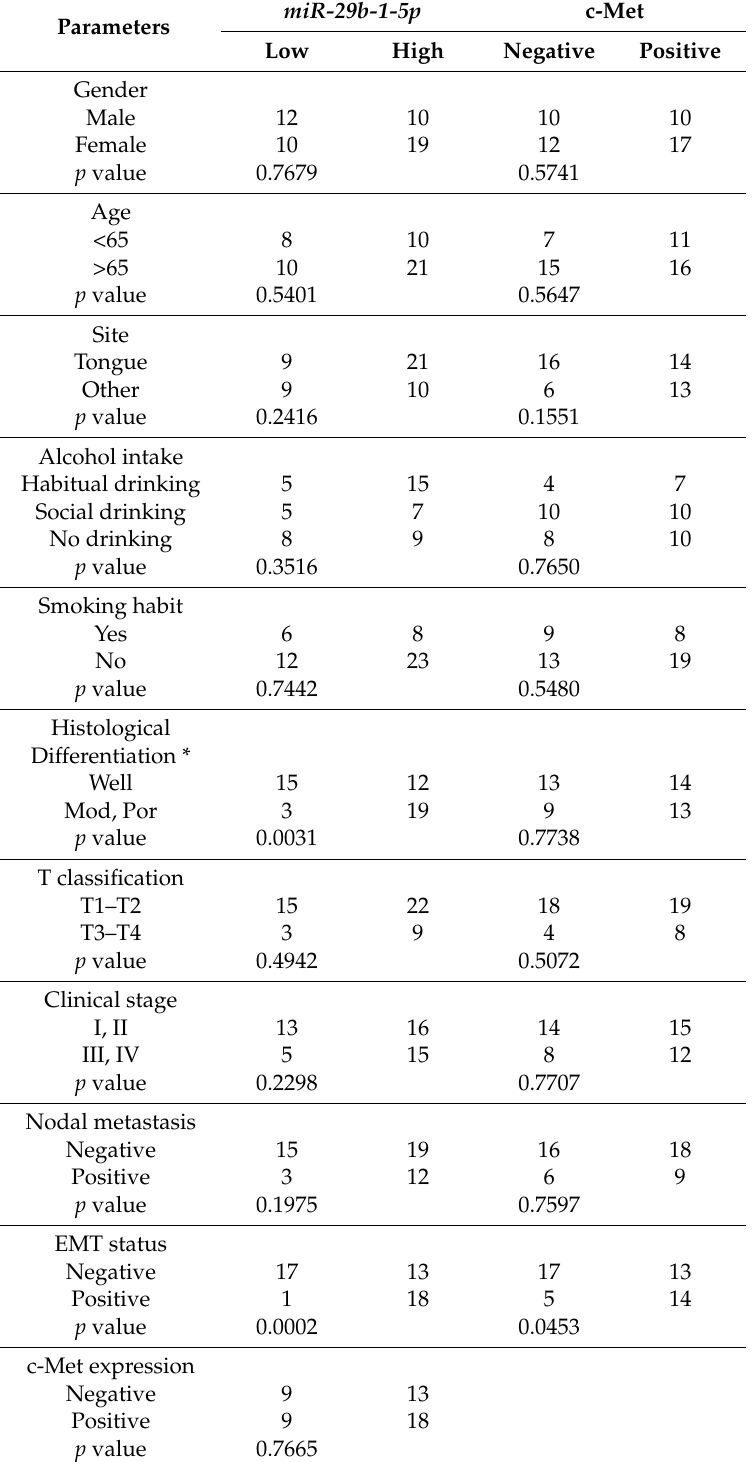
Table 1. Relationship between miR-29b-1-5p or c-Met expression and clinicopathological